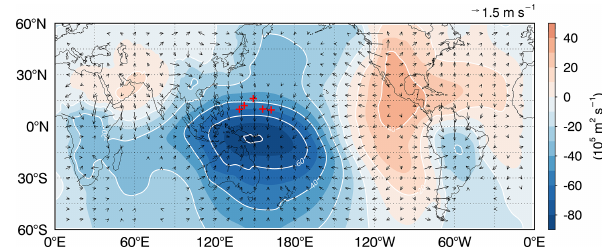
Figure 4. Climatic means of velocity potential (shading) and diver- gent wind fields (arrows) at 850hPa in DJF derived from reanalysis data during 2005–2019. The red pluses denote the five radiosonde